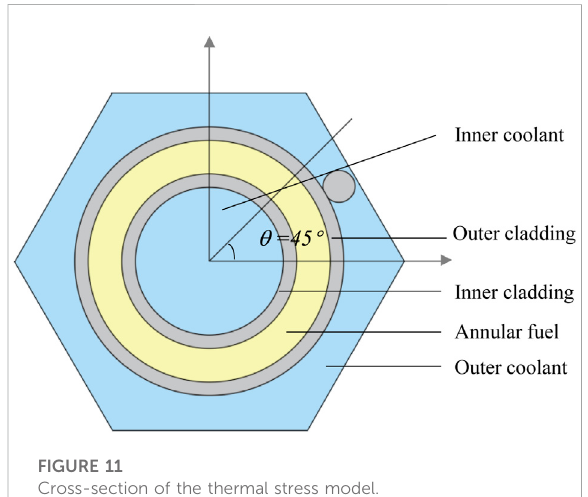
FIGURE 11 Cross-section of the thermal stress